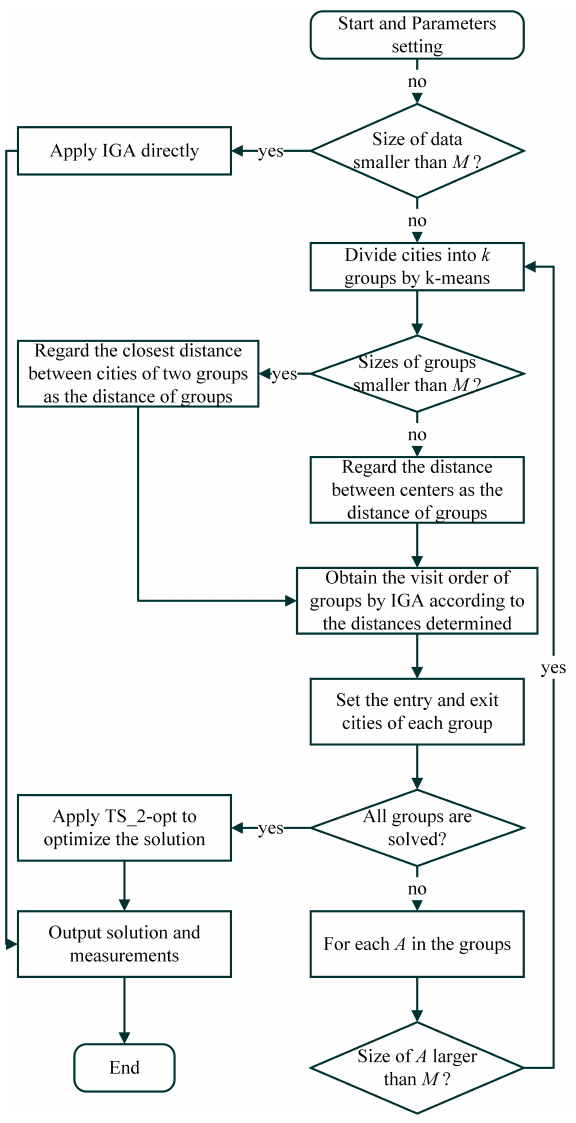
Figure 2. Main steps of the novel